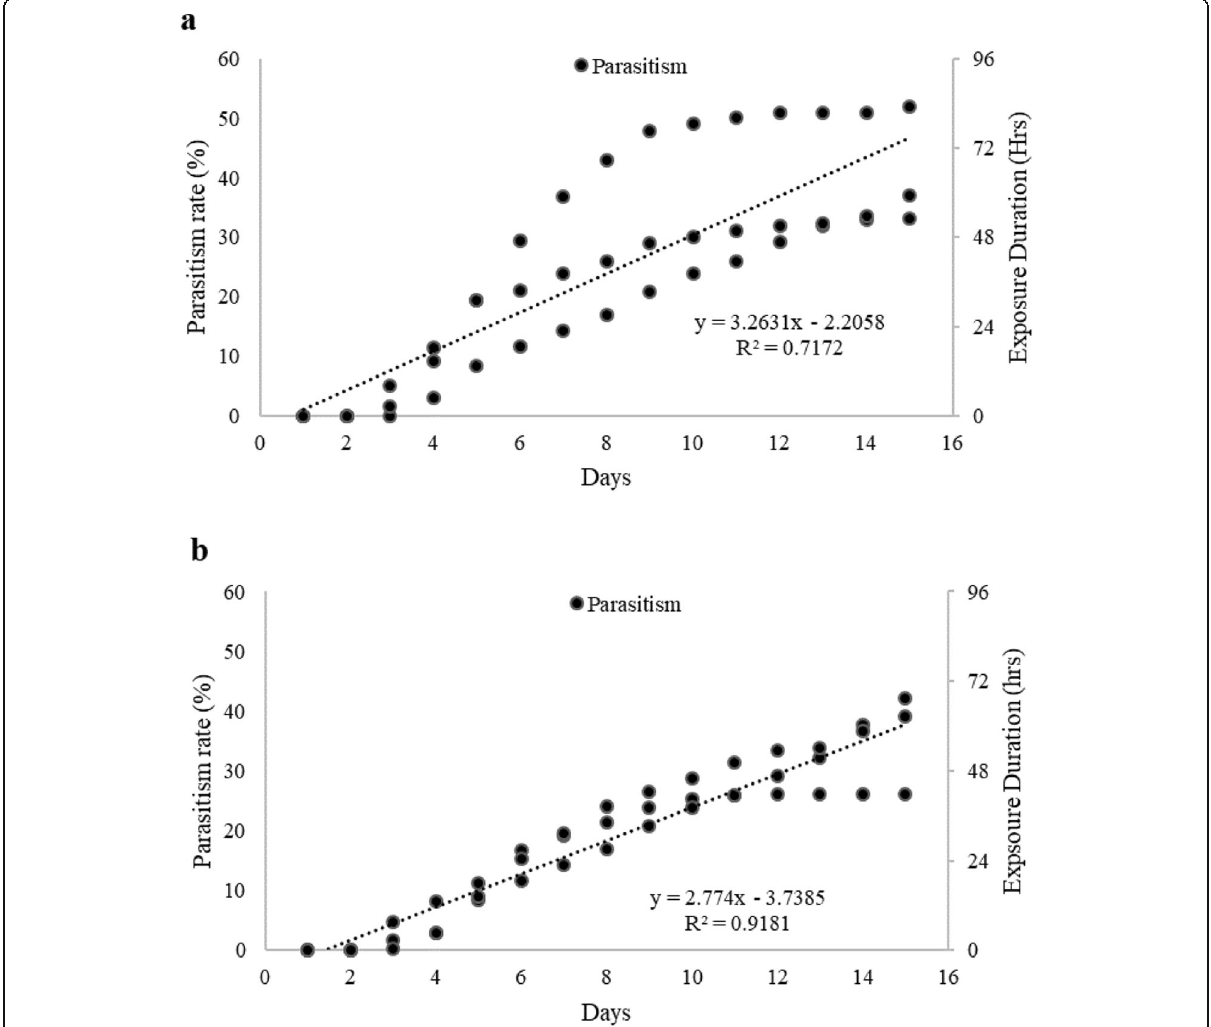
Fig. 2 Correlation between parasitism rate of Dirhinus giffardii and exposure duration a Zeugodacus cucurbitae and b Bactrocera dorsalis